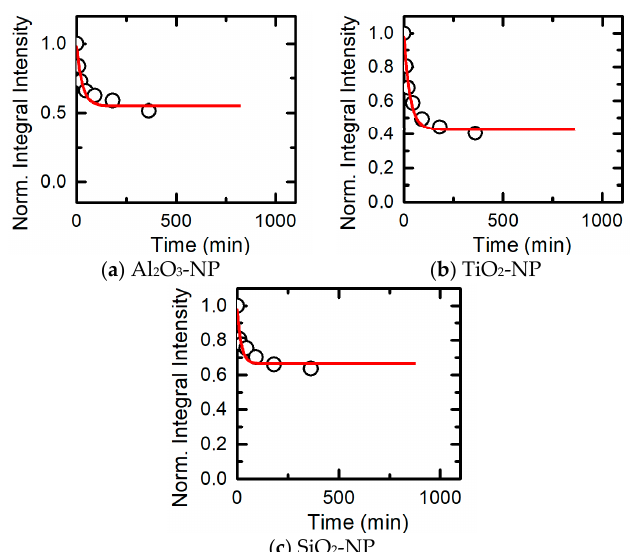
Figure 5. The kinetics of nanoparticle dissolution in suspension upon addition of FBS. Circles correspond to actual measurements at different time points during first 300 min, the red lines - to their approximation by exponential equations of the general formula: A + B exp( − t/ τ ) extrapolated to the 750 min.